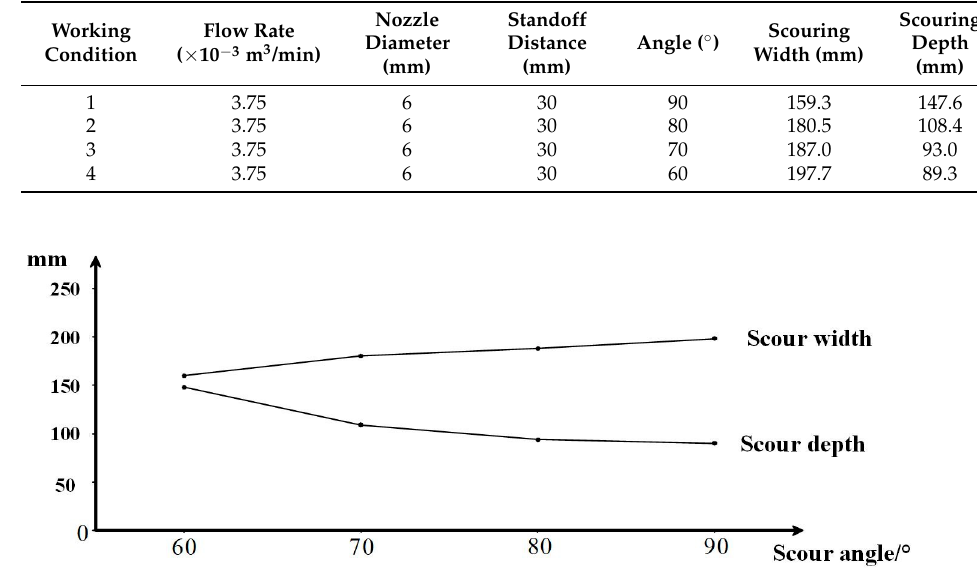
Figure 20. Scour depth and width at different jet inclination angles.